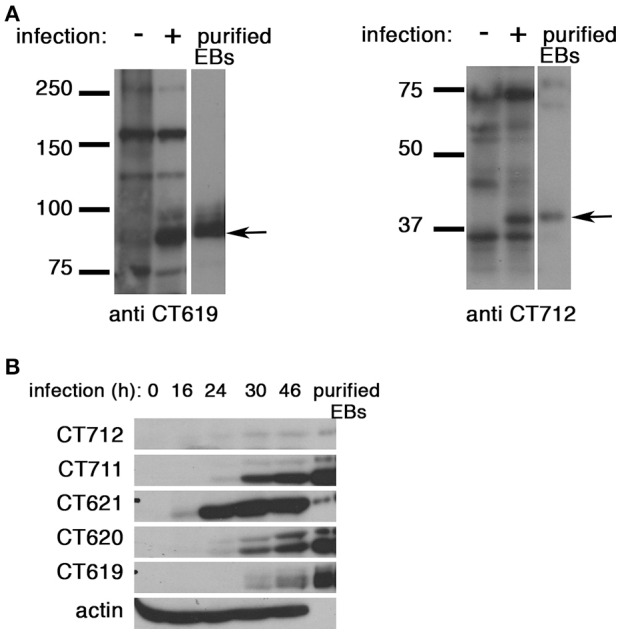
All DUF582 proteins, except CT621, accumulate in EBs. (A) Cell lysates from uninfected cells or cells infected for 32 h, and gradient purified EBs, were lysed in 8 M urea buffer (see methods). Proteins were separated on SDS-PAGE (10% for CT619, 12% for CT712), transferred on a PVDF membrane and probed with the indicated rabbit polyclonal antibody. CT619 (expected mw = 97 kD) runs as a double band, while CT712 (expected mw = 44 kD) runs as a single species. (B) HeLa cells were infected with C. trachomatis L2 for the indicated times before lysis in 8 M urea buffer. Gradient purified EBs, lysed in the same buffer, were loaded in the right lane for comparison. Identical samples were loaded on separate gels and probed with the indicated polyclonal rabbit antibodies. Actin was used as a loading control, and also shows the good purification of the EBs. CT712 expression is hardly detected. This might reflect a low expression, and/or sub-optimal detection with this antibody.